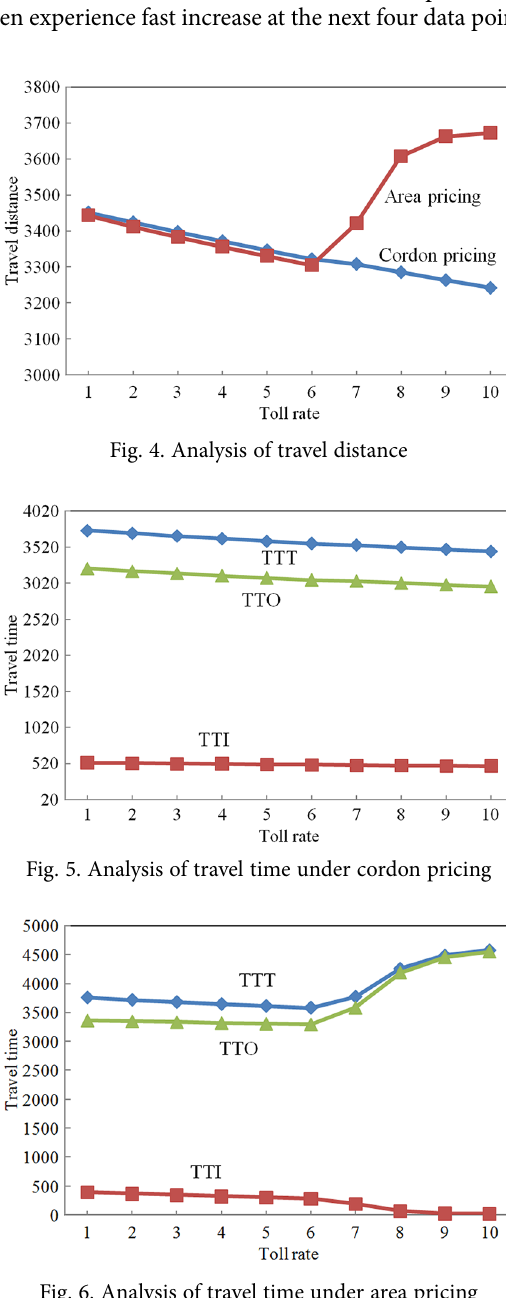
Fig. 6. Analysis of travel time under area